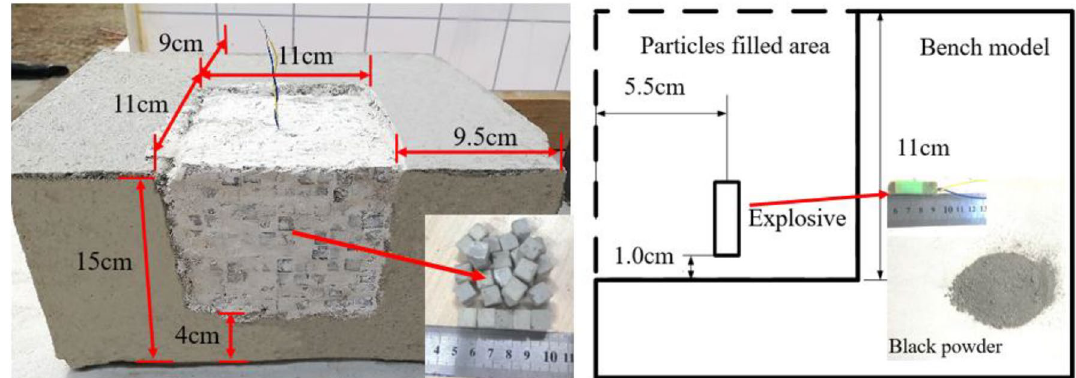
Figure 1. Specimen of concrete bench test and preparation of